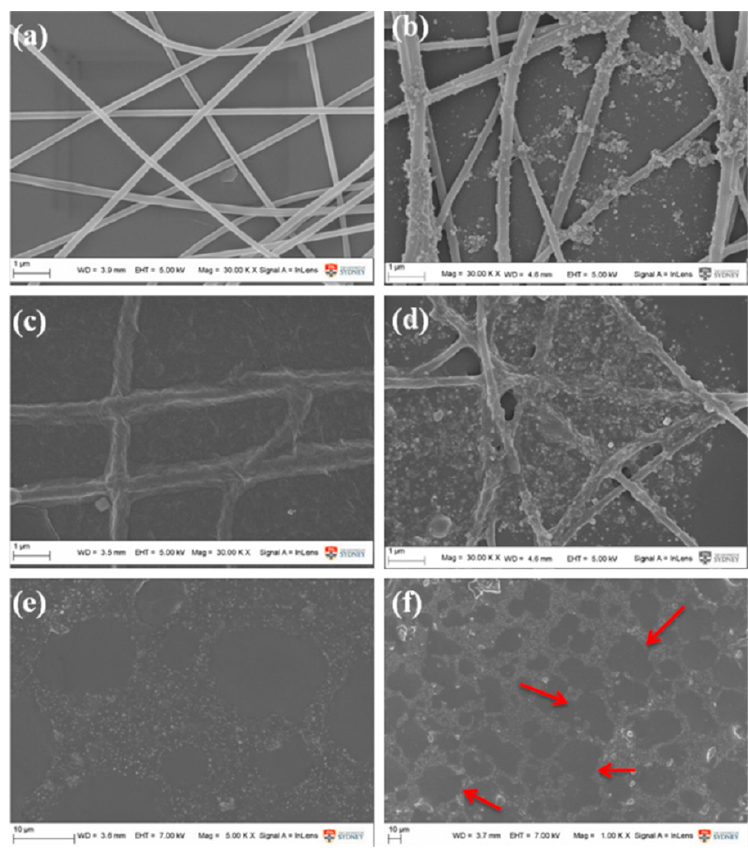
Figure 10. High-resolution SEM images of polyurethane (PU) nanofibrous mats. ( a ) Electrospun for 180 s. PU nanofibrous electrospun for 180 s dipped with ( b ) silver phosphate nanometer particles (AgNPs), ( c ) graphene nano solution (GNSs), ( d ) AgNPs–GNSs (5:1) and ( e ) AgNPs–GNSs (3:1) after melting. ( f ) shows SEM micrograph of ( e ) under low magnification. (Adapted from